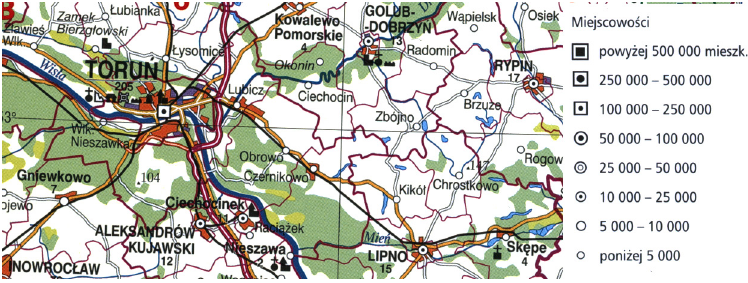
Fig. 2. Symbols on the general reference